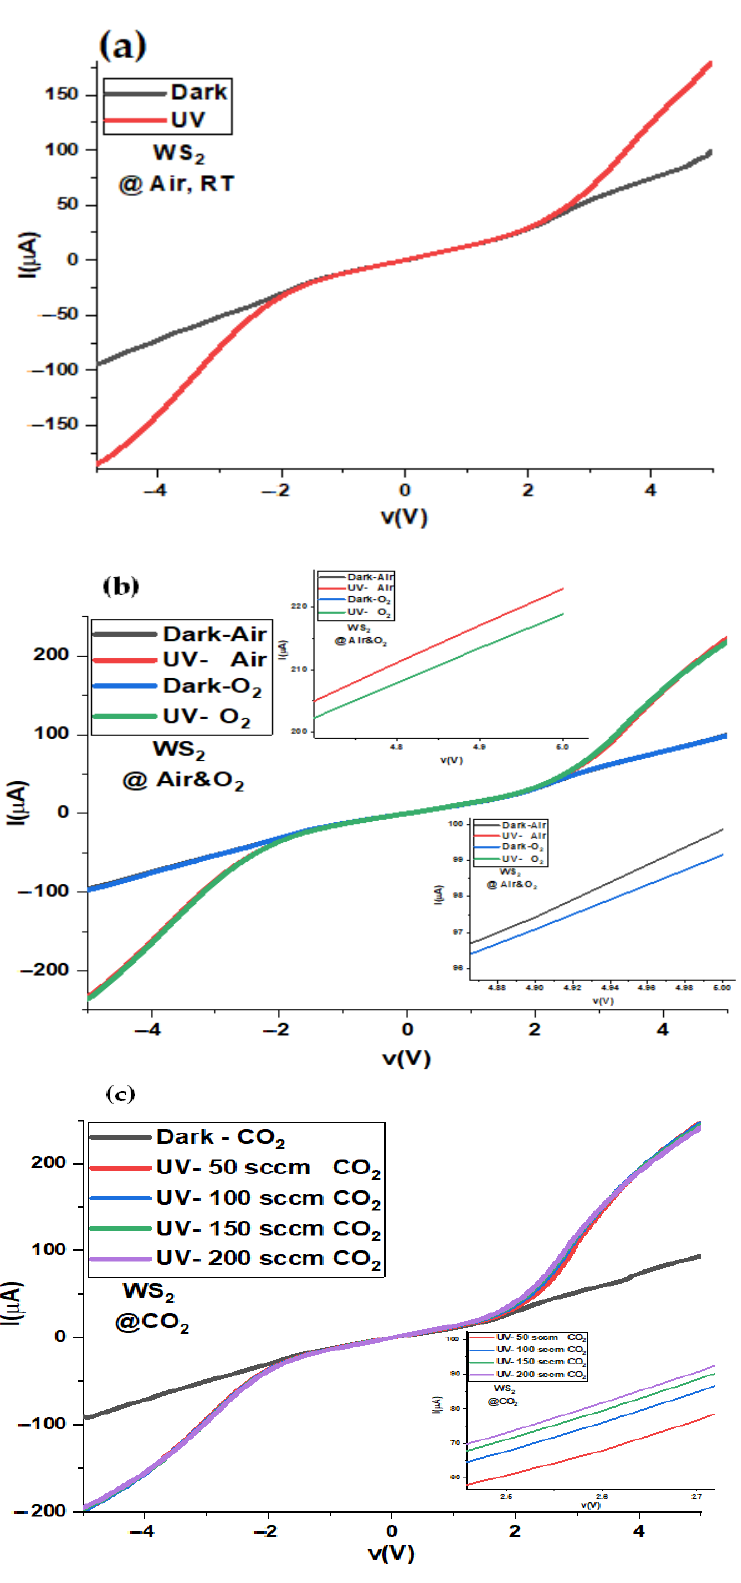
Figure 11. Characteristic I-V curve of WS 2 under dark and UV illumination conditions under ( a ) air environment, ( b ) O 2 environment and ( c ) CO 2 environment. Normally, O 2 and CO 2 are oxidizing gases due to their high affinity for electrons and high electronegativity. However, in the case of CO 2 molecules, the electronegativity is stronger than in the O 2 case. We observed an increase in the photocurrent under the CO 2 environment in Figure 11c. The photocurrent is increased with increasing the CO 2 concen- trations from 50 to 200 sccm. The p-type semiconductor behavior of WS2 under CO2 ad- sorption increases the total current as observed here in Figure 11. To check the WS 2 film stability under air, we measured the photocurrent behavior as a function of time of WS 2 thin film under the dark condition in the air at a different bias voltage of 0, 0.5, 1, and 2 V, as demonstrated in Figure 12a. In the case of WS 2 , we found that the film became more stable at low bias voltage, in contrast to the case of MoS 2 , so we did not test the WS 2 films at higher bias voltage. By increasing the bias voltage, the current was increased. However, by applying 2 V, the current reached higher values. Consequently, the on–off behavior of WS 2 thin film was tested under the same applied biases of 0, 0.5, 1, and 2 V and is depicted in Figure 12b. At 0 V bias, for the dark current in the air, almost no current is observed with some signal noises. But under O 2 stimuli, we observed a negative current behavior as in Figure 12b, indicating that WS 2 can work as a negative photoresponse optical detec- tor under low biases [40]. However, at 0.5, 1, and 2 V bias, the current becomes positive for under air and O 2 environments. At 0.5 and 1 V, there were almost no changes in the current under air and O 2 gas environments. The best current response was observed at 2 V for both air and O 2 environments with the same behavior, as expected (Figure 12b).